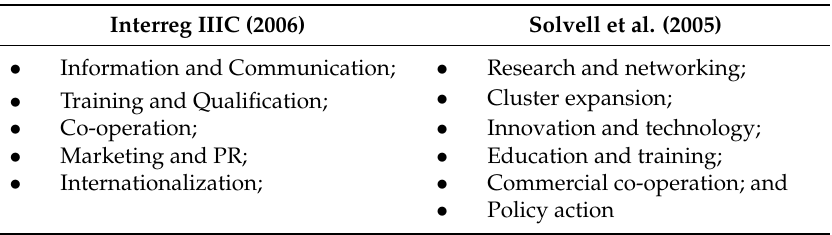
Table 1. Typologies for grouping activities of cluster associations.